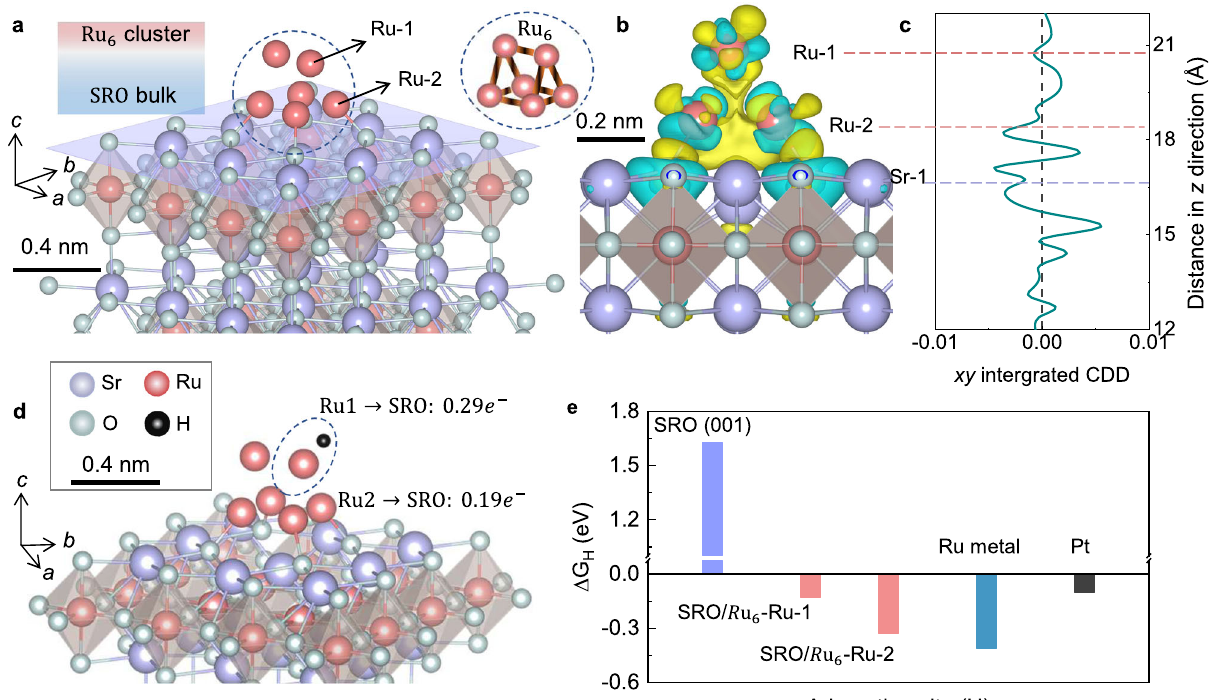
Fig. 4 | Mechanism of the HER process at the surface of reconstructed SRO. a Optimized adsorption geometry for the Ru 6 cluster at the (001) surface of SRO. Ru1andRu2representtheRusitethatbindingwiththeSROandabovethesurface. The Ru cluster with D 3h geometry is given for reference. b Charge-density differ- en c e and c the corresponding plane-averaged charge-density difference (right)